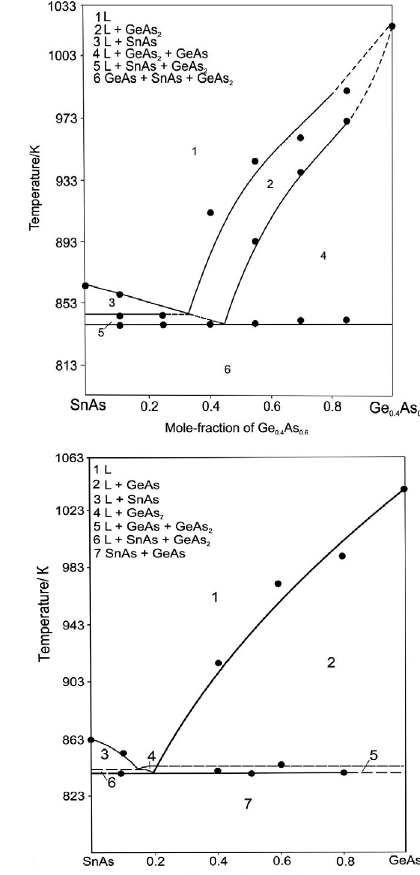
0.4 As 0.6 (а) and SnAs–GeAs (b).